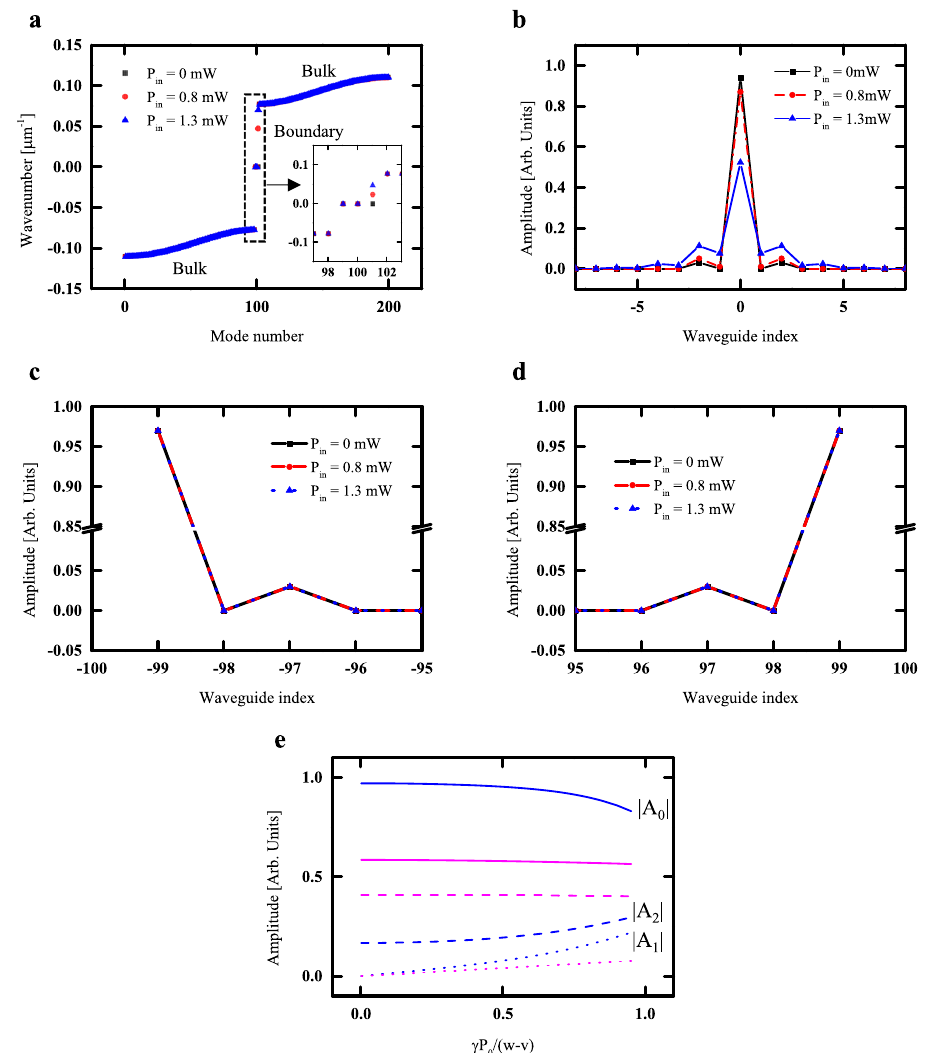
Fig. 5 | The topological boundary state tuned by the Kerr nonlinearity. a Band diagramofthetopologicalwaveguidefordifferentinputpower.Distributionofthe wave function for the b boundary mode, c left-hand edge mode, and d the right-